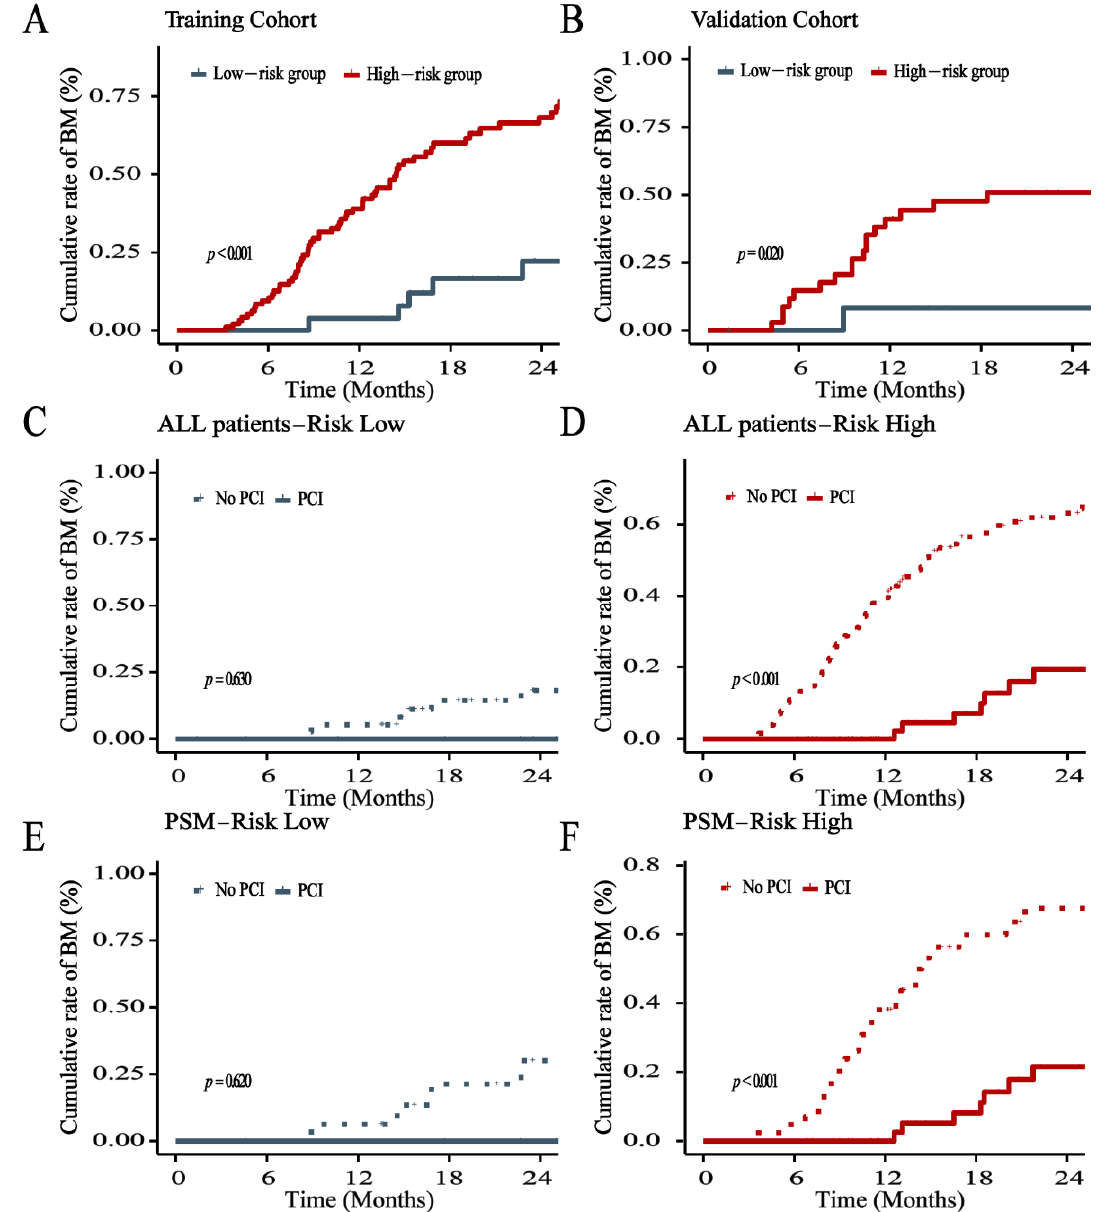
Figure 7. Proportion of patients with brain metastases in training ( A ) and validation ( B ), low-risk cohort ( C ), and high-risk cohort ( D ) before matched. The proportion of patients with brain metastasis in the low-risk and high-risk cohorts after PSM ( E , F ).